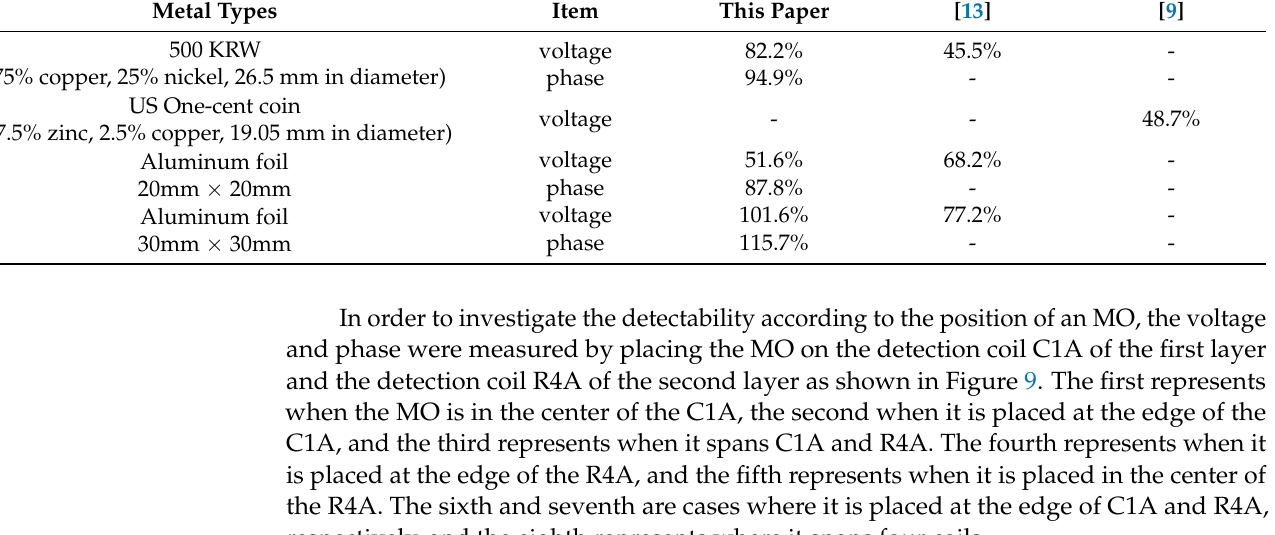
Table 3. Comparison of voltage and phase variation with previous papers.